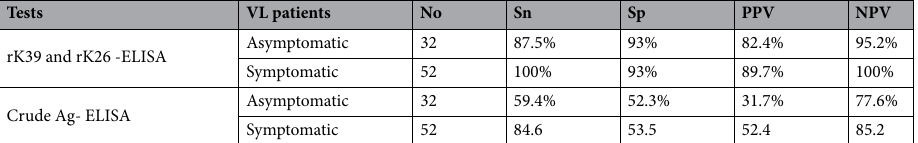
Table 4. Sensitivity, specificity, positive predictive value, and negative predictive value of Crude Ag and mixed rK39 and rK26—antigens compared to DAT for serodiagnosis of symptomatic and asymptomatic VL patients. Sn Sensitivity, Sp Specificity, PPV Positive predictive value, NPV Negative predictive value.